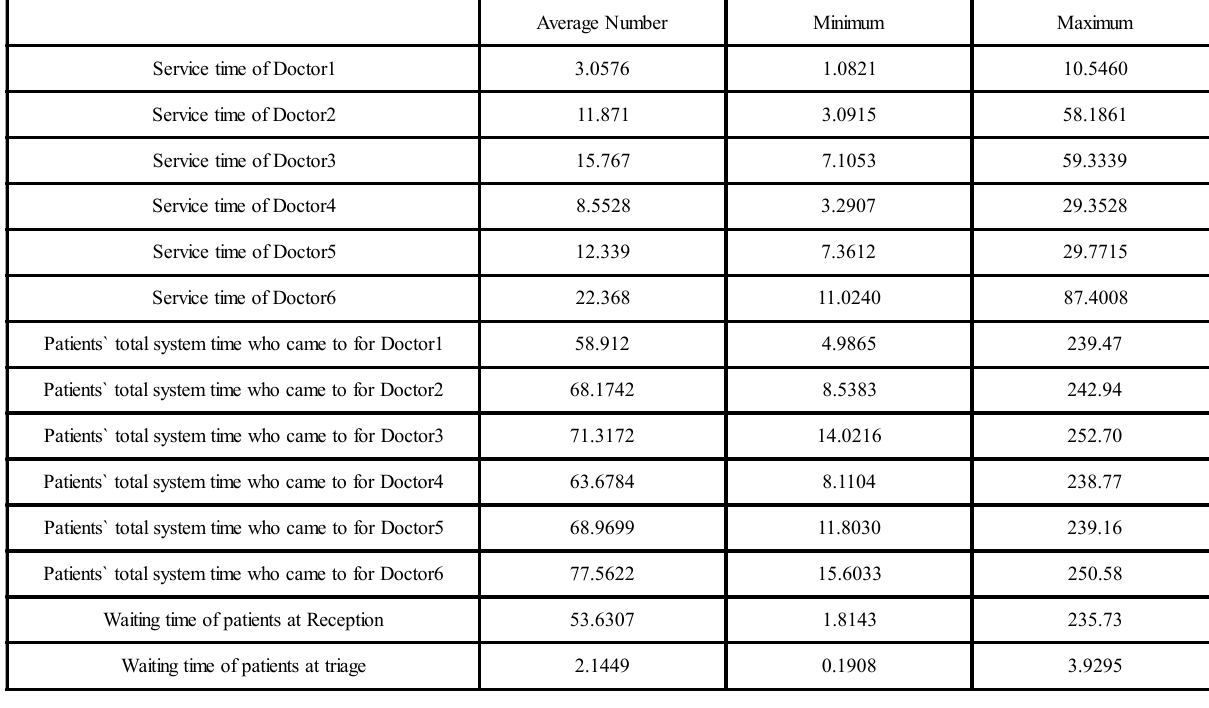
TABLE 7. PATIENTS‘ SERVICE TIME AND THEIR TOTAL SYSTEM